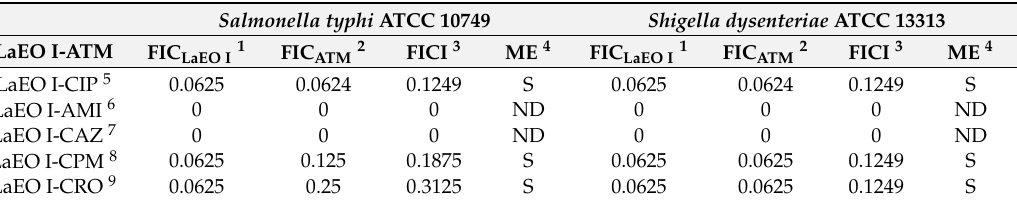
Table 3. Modulatory effect of LaEO I on the activity of clinically used antimicrobial agents on Salmonella typhi and Shigella dysenteriae strains.